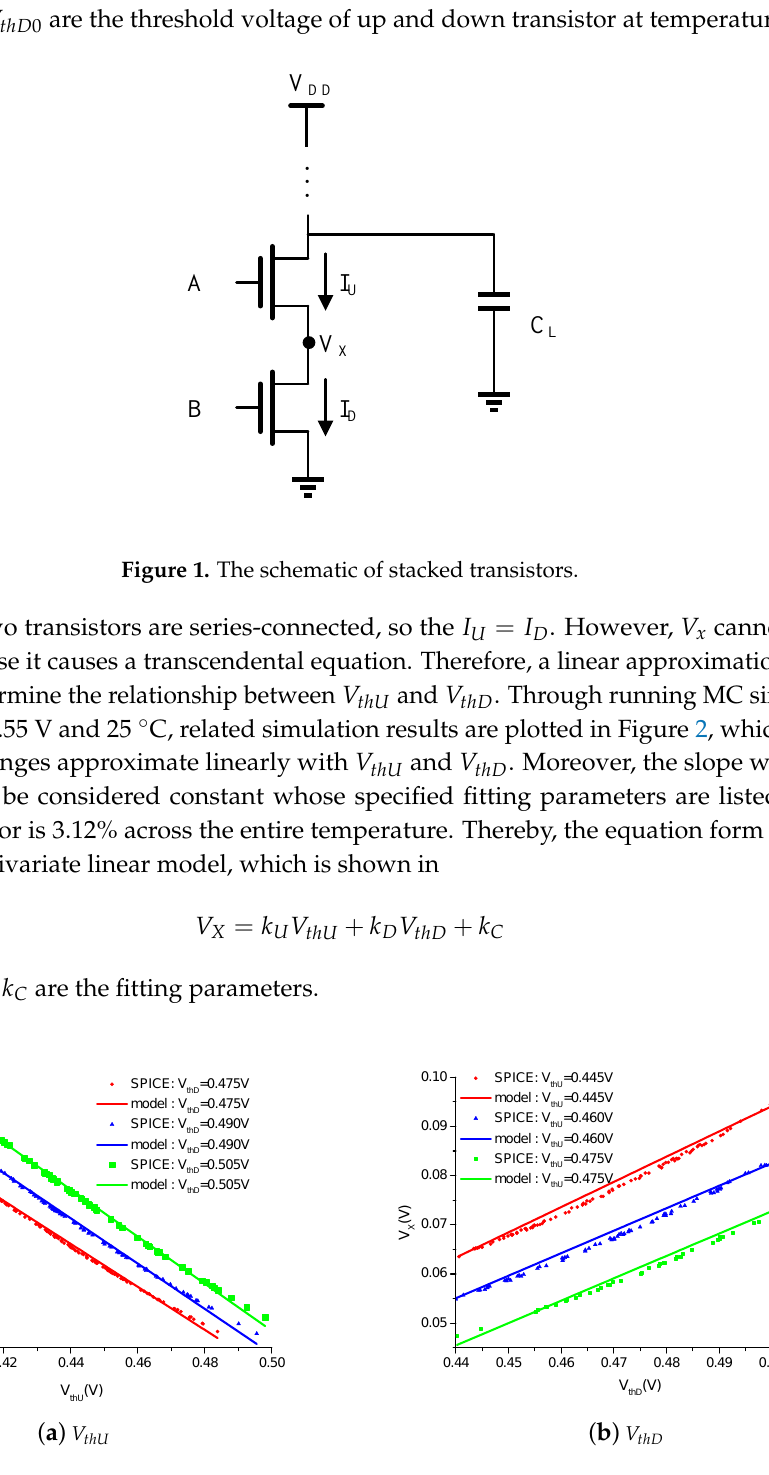
Figure 2. The relationship of V x with V thU and V thD : ( a ) V thU ; ( b ) V thD